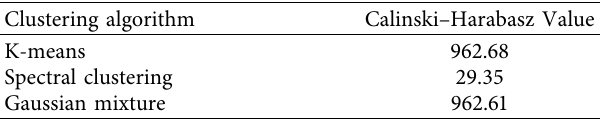
Figure 7: Optimal number of clusters with the elbow method for Scenario 2. Table 6: Calinski–Harabasz values for different clustering algorithms for Scenario